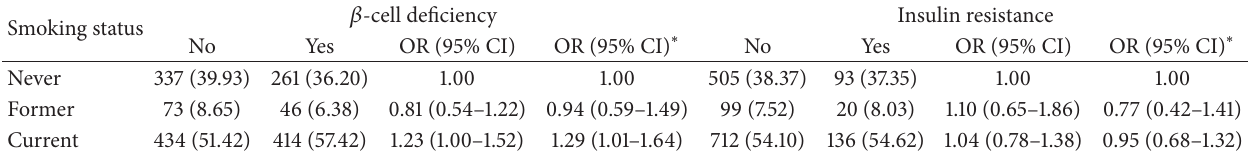
Table 3: The associations between smoking status and 𝛽 -cell deficiency and insulin resistance.